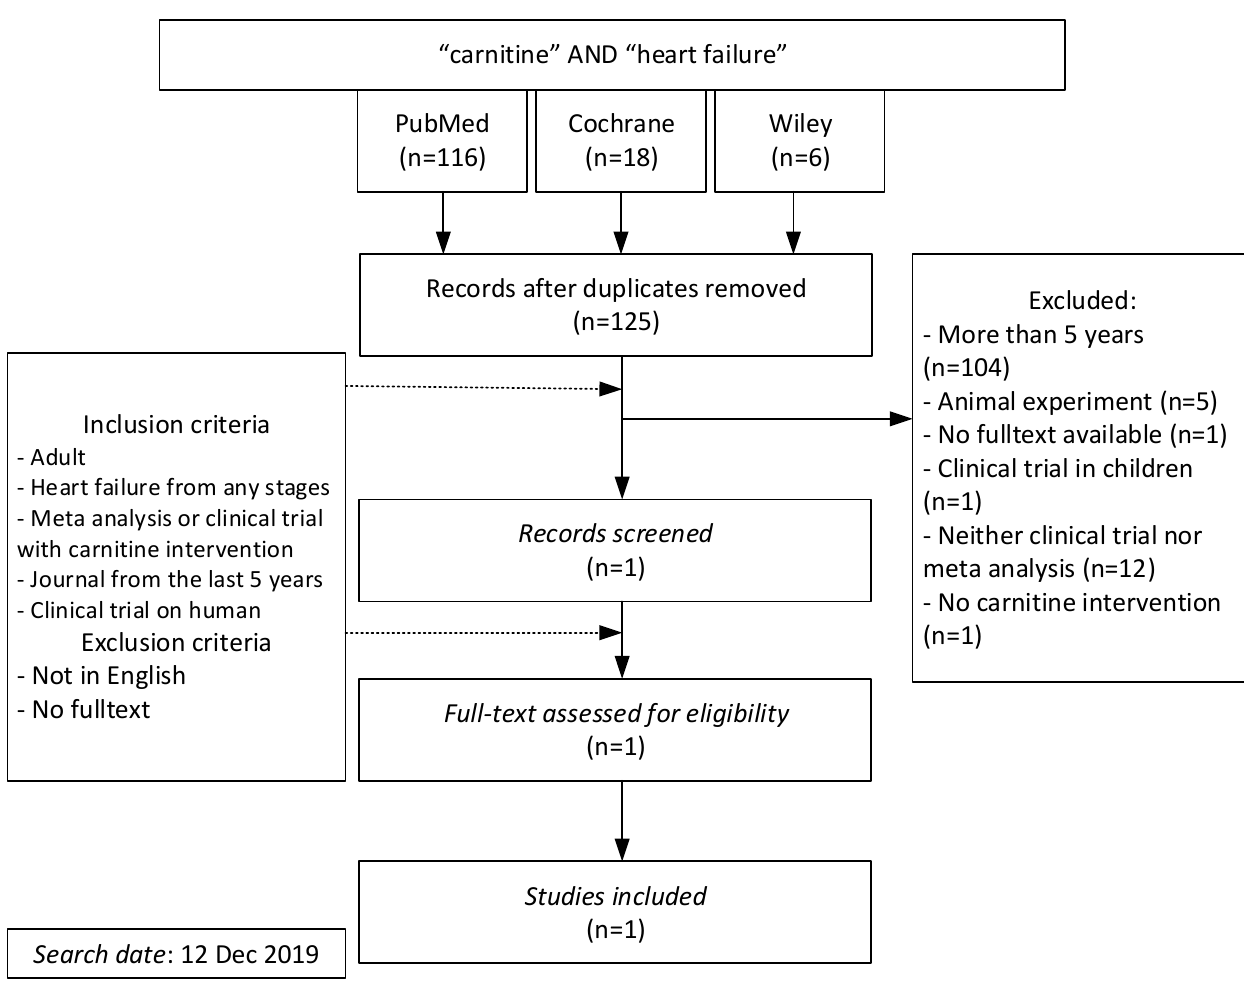
Figure 1. PRISMA flow